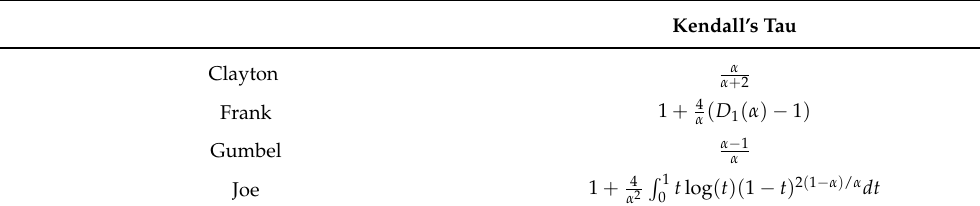
Table A2. Kendall’s tau correlation coefficient as a function of the copula dependence parameter α